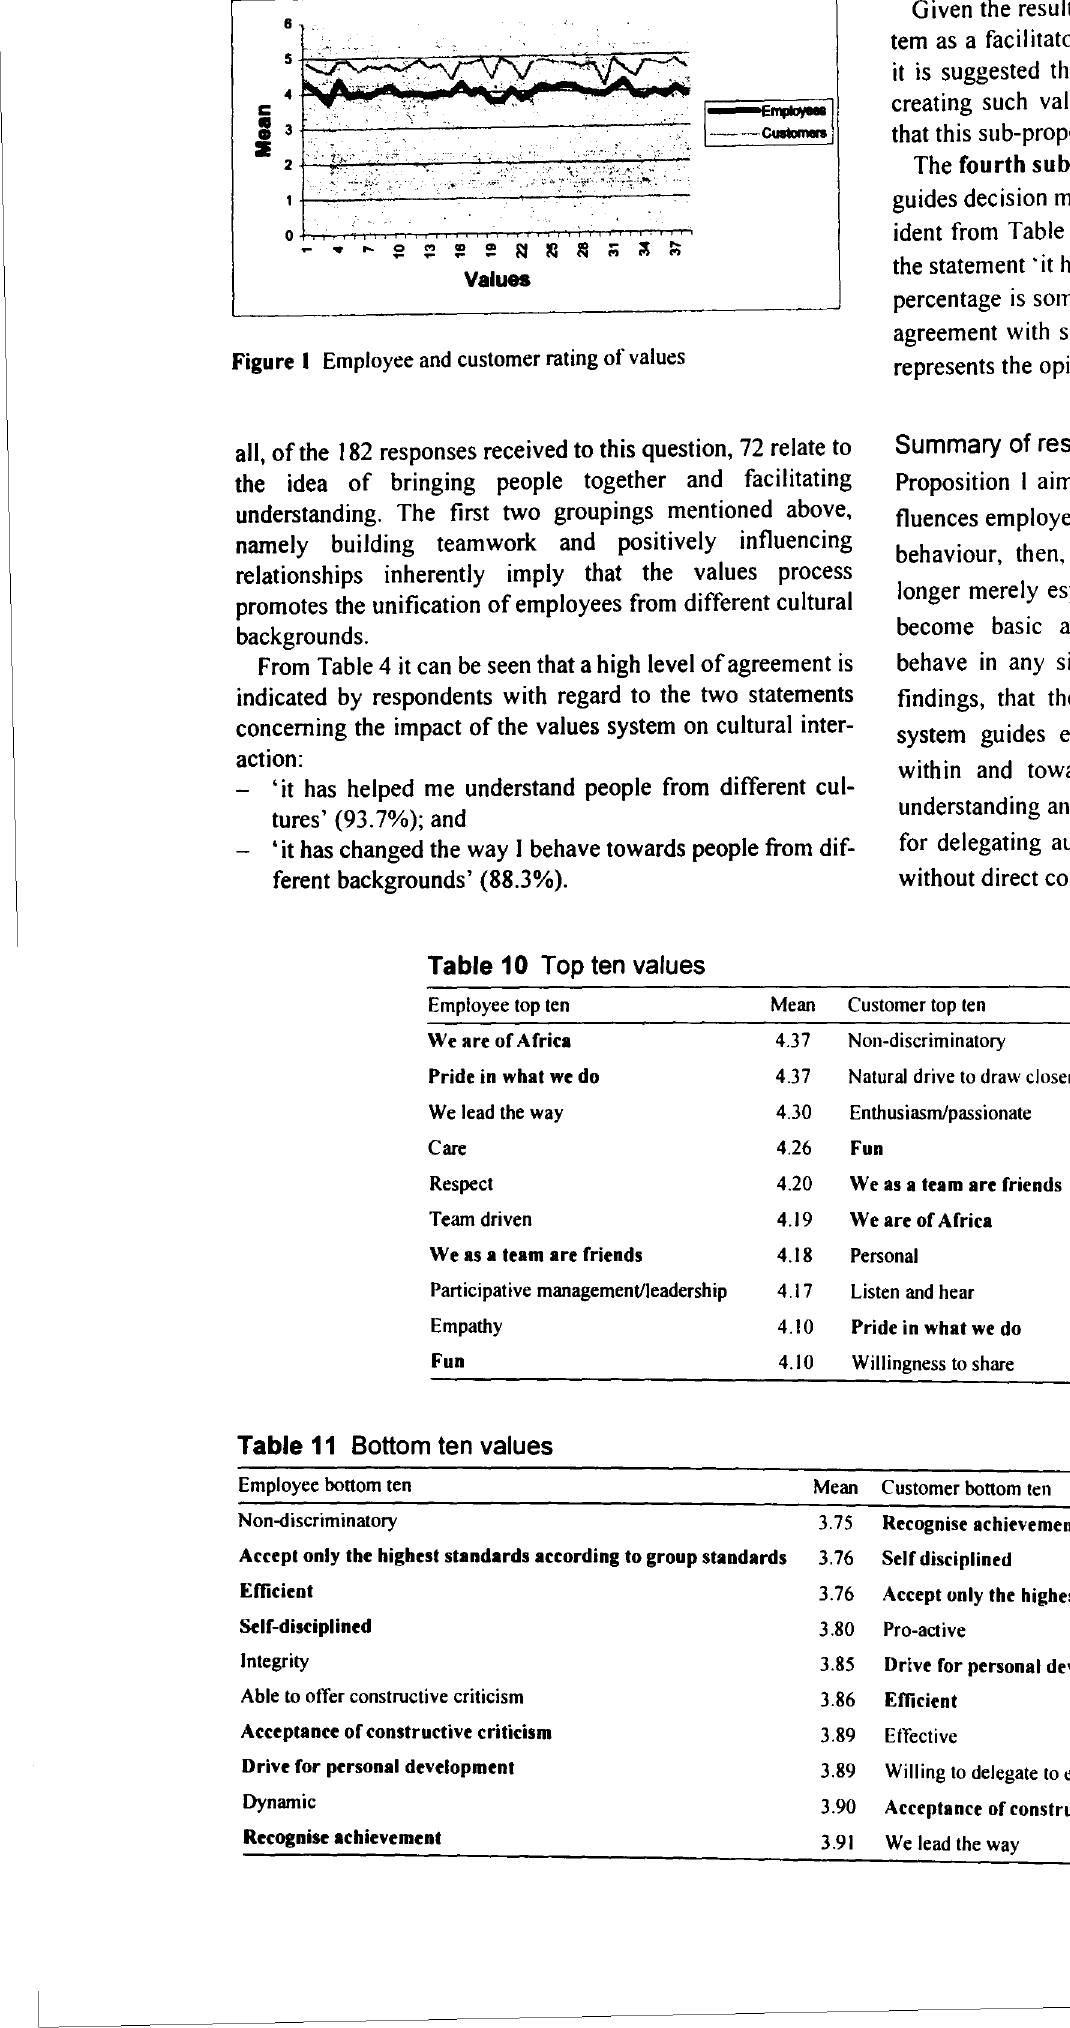
Employee bottom ten Non-discriminatory Accept only the highest standards according to group